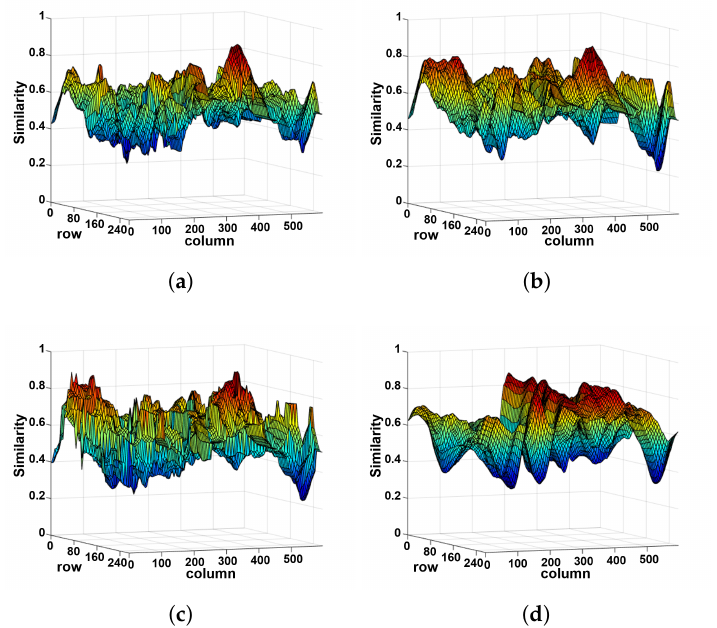
Figure 12. Three-dimensional profiles of similarity. ( a ) Profile of ABC similarity. ( b ) Profile of CI similarity. ( c ) Profile of CCH similarity. ( d ) Profile of TFCM similarity.